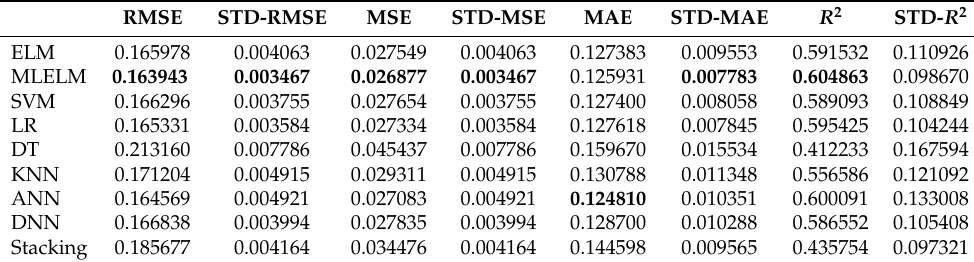
Table 3. The performance of various models for annual building energy consumption: fifteenfold division. RMSE STD-RMSE MSE STD-MSE MAE STD-MAE R 2 STD- R 2 ELM 0.165978 0.004063